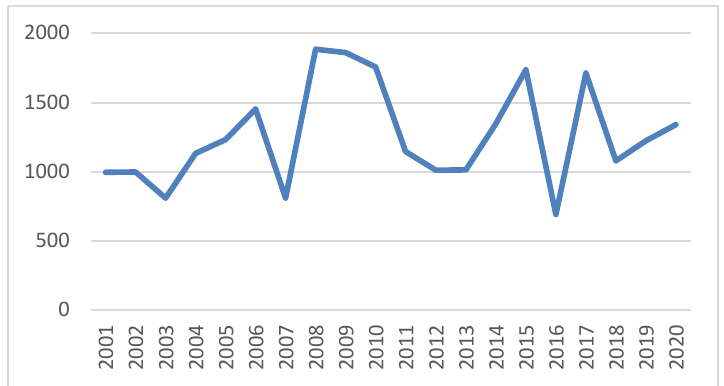
Figure: 1 Annual rainfall in Nagapattinam district from